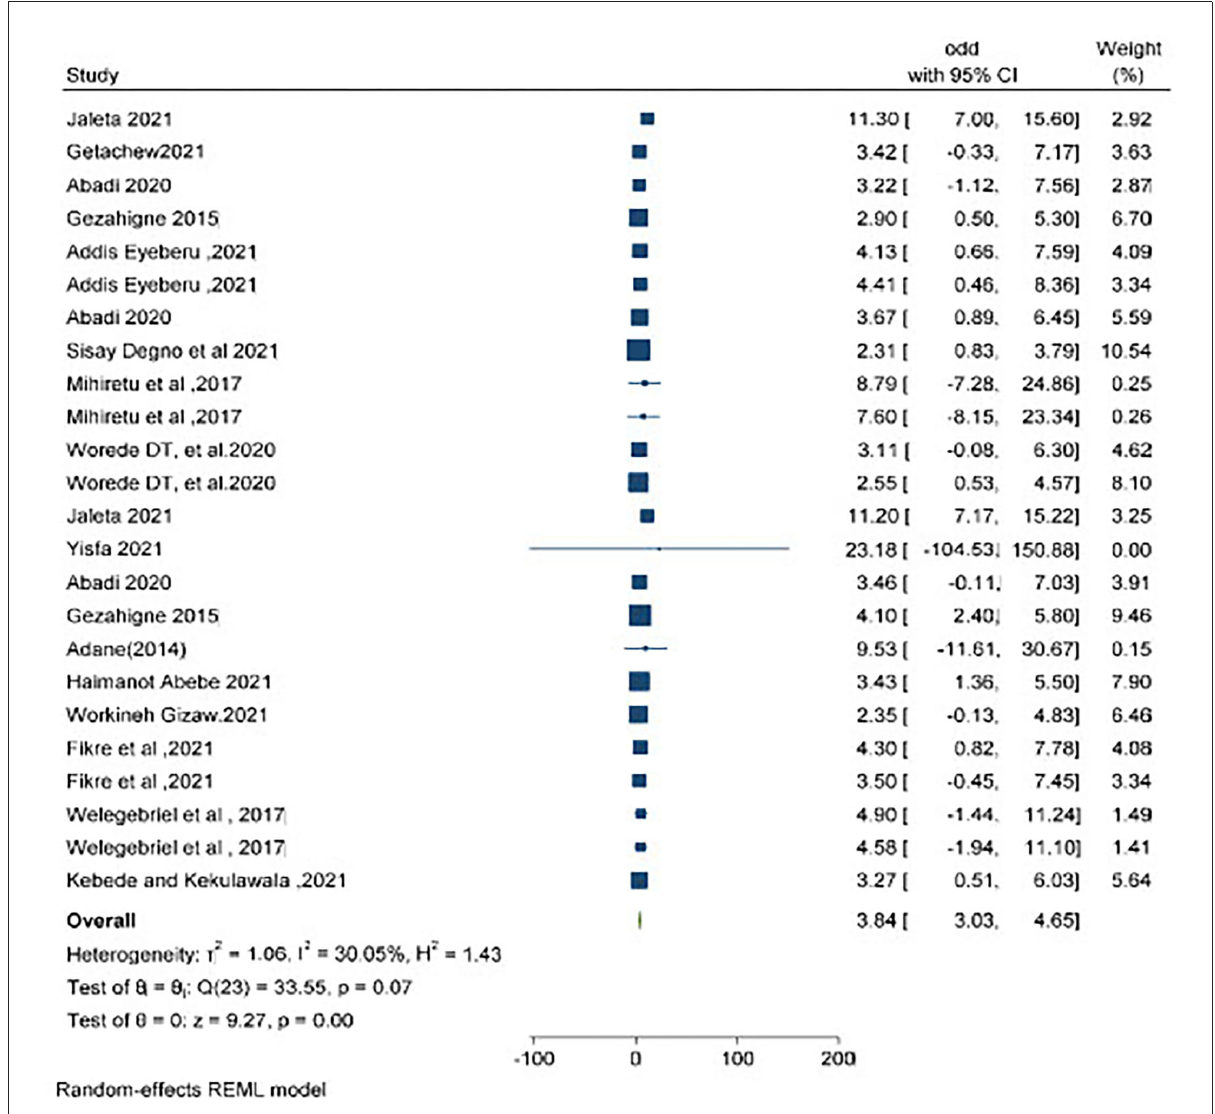
FIGURE6 Comparison of prenatal death using CMA and STATA.